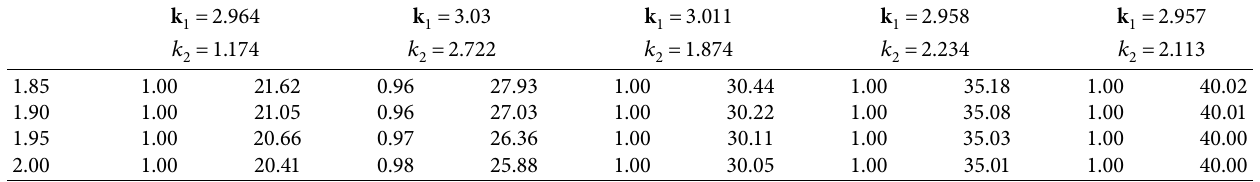
Table 3: ARL and ASS of the Rayleigh distribution under time truncated life test for ARL � k 1